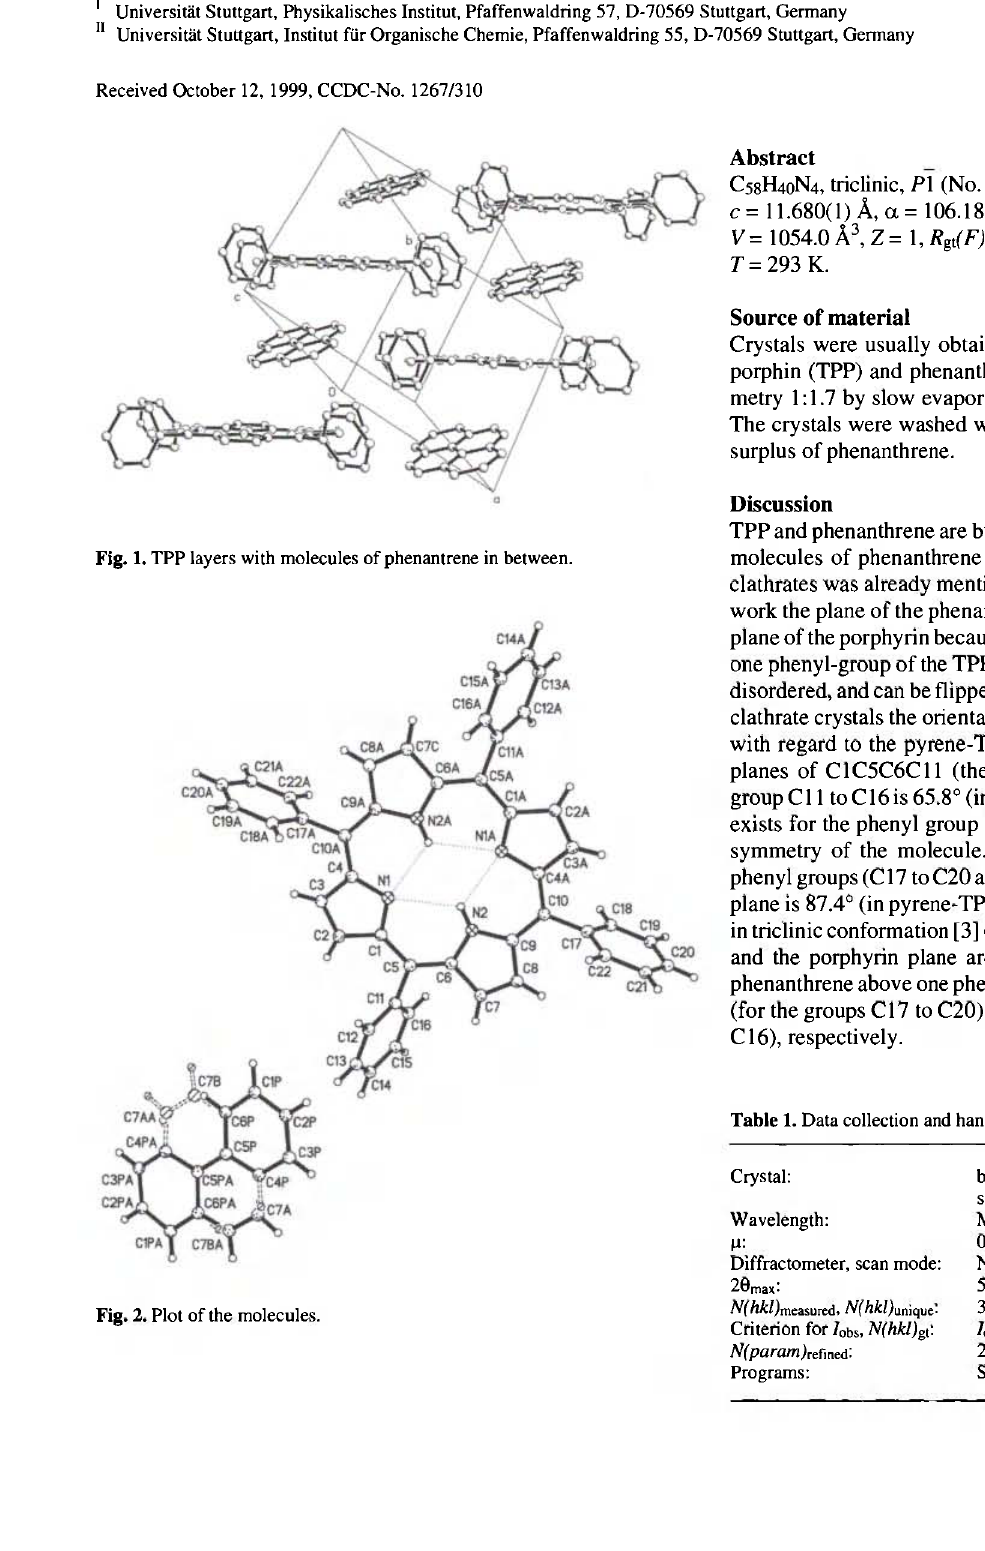
Fig. 2. Plot of the